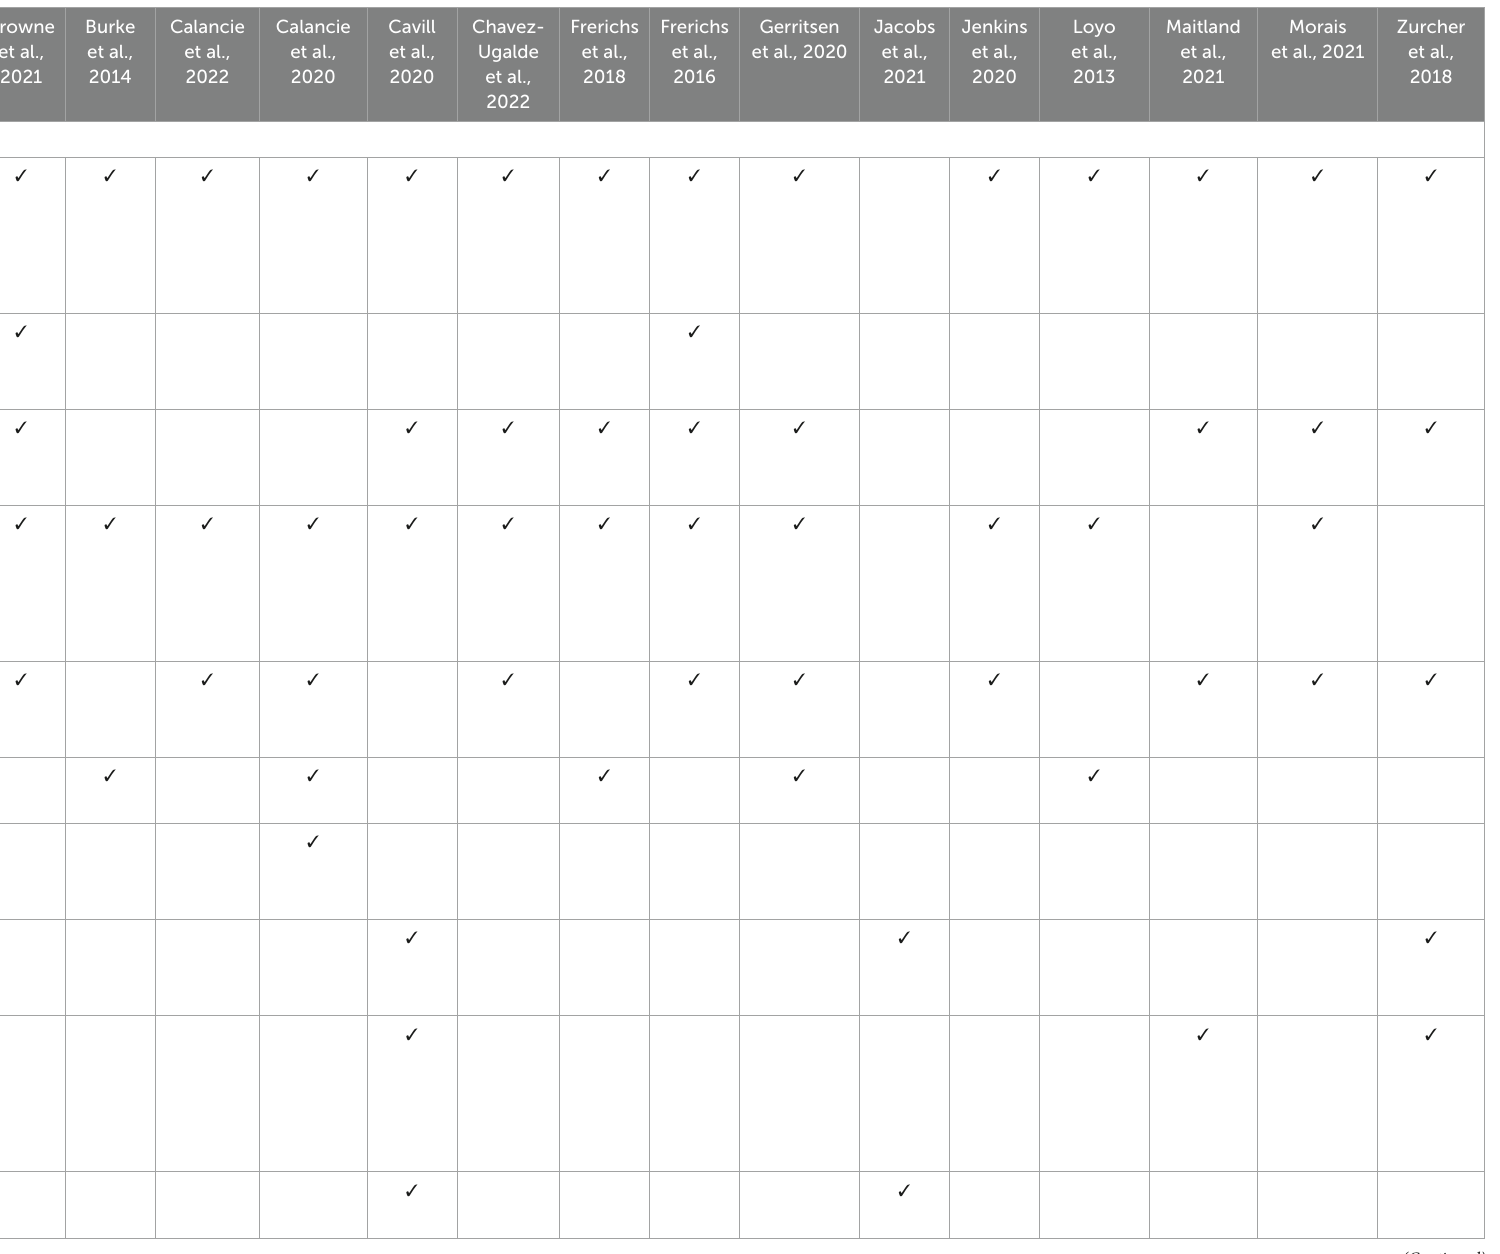
TABLE 4 Measures of success by author for 16 articles that measure